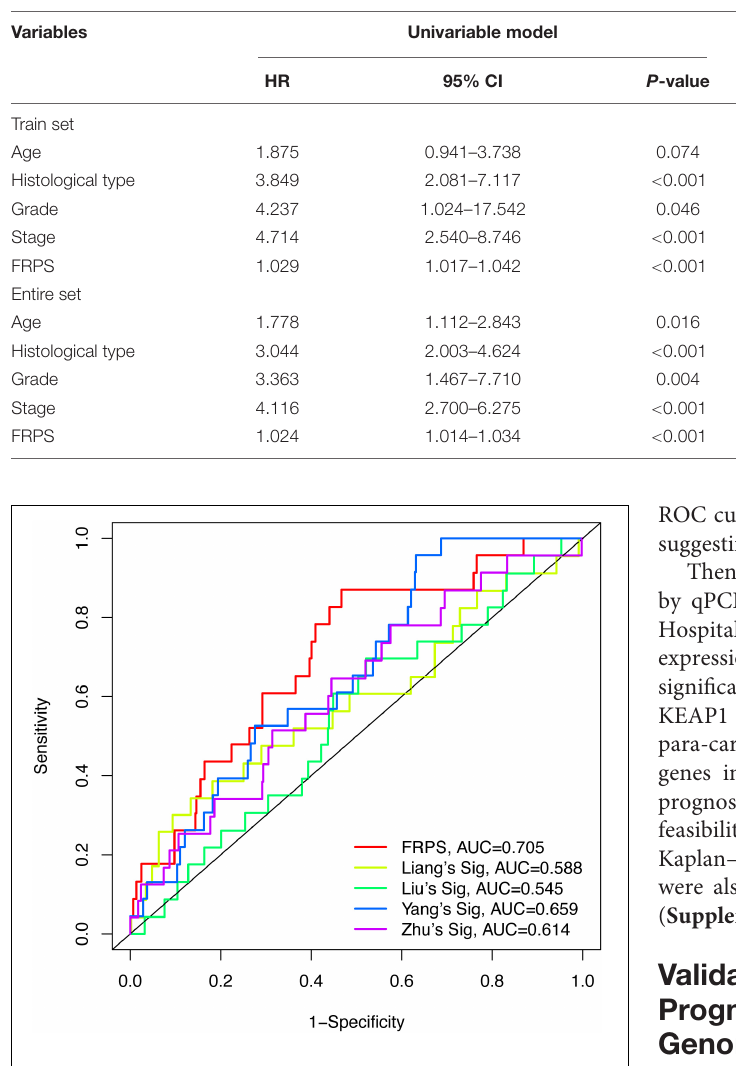
FIGURE 4 | The AUC for FRPS and the existing ferroptosis-related signatures.